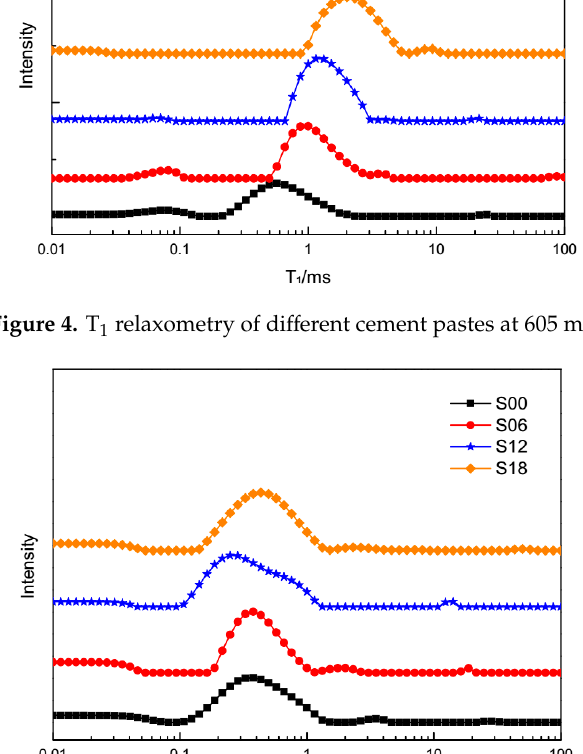
Figure 5. T 1 relaxometry of different cement pastes at 1210 min.